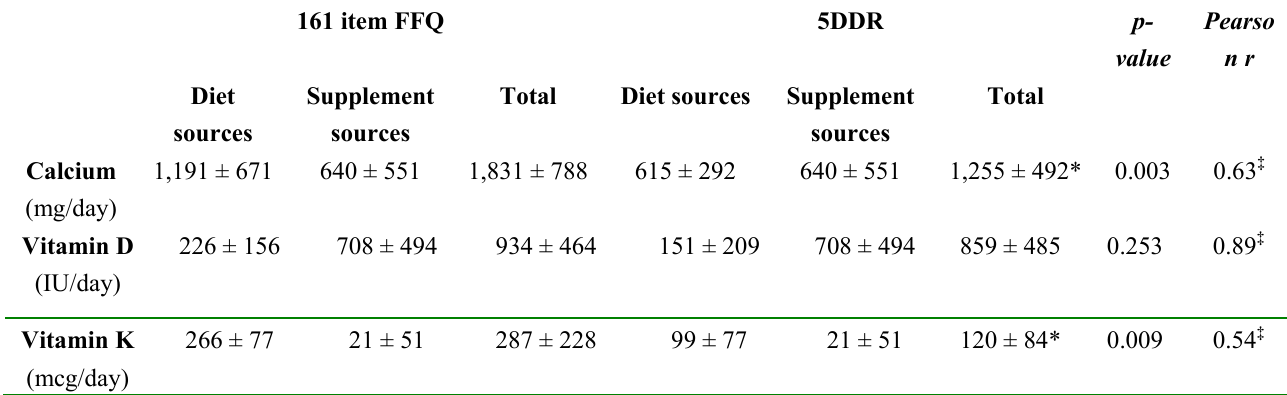
Table 2. Nutrient intakes (mean ± SD) derived from FFQ and 5DDR, and correlation between